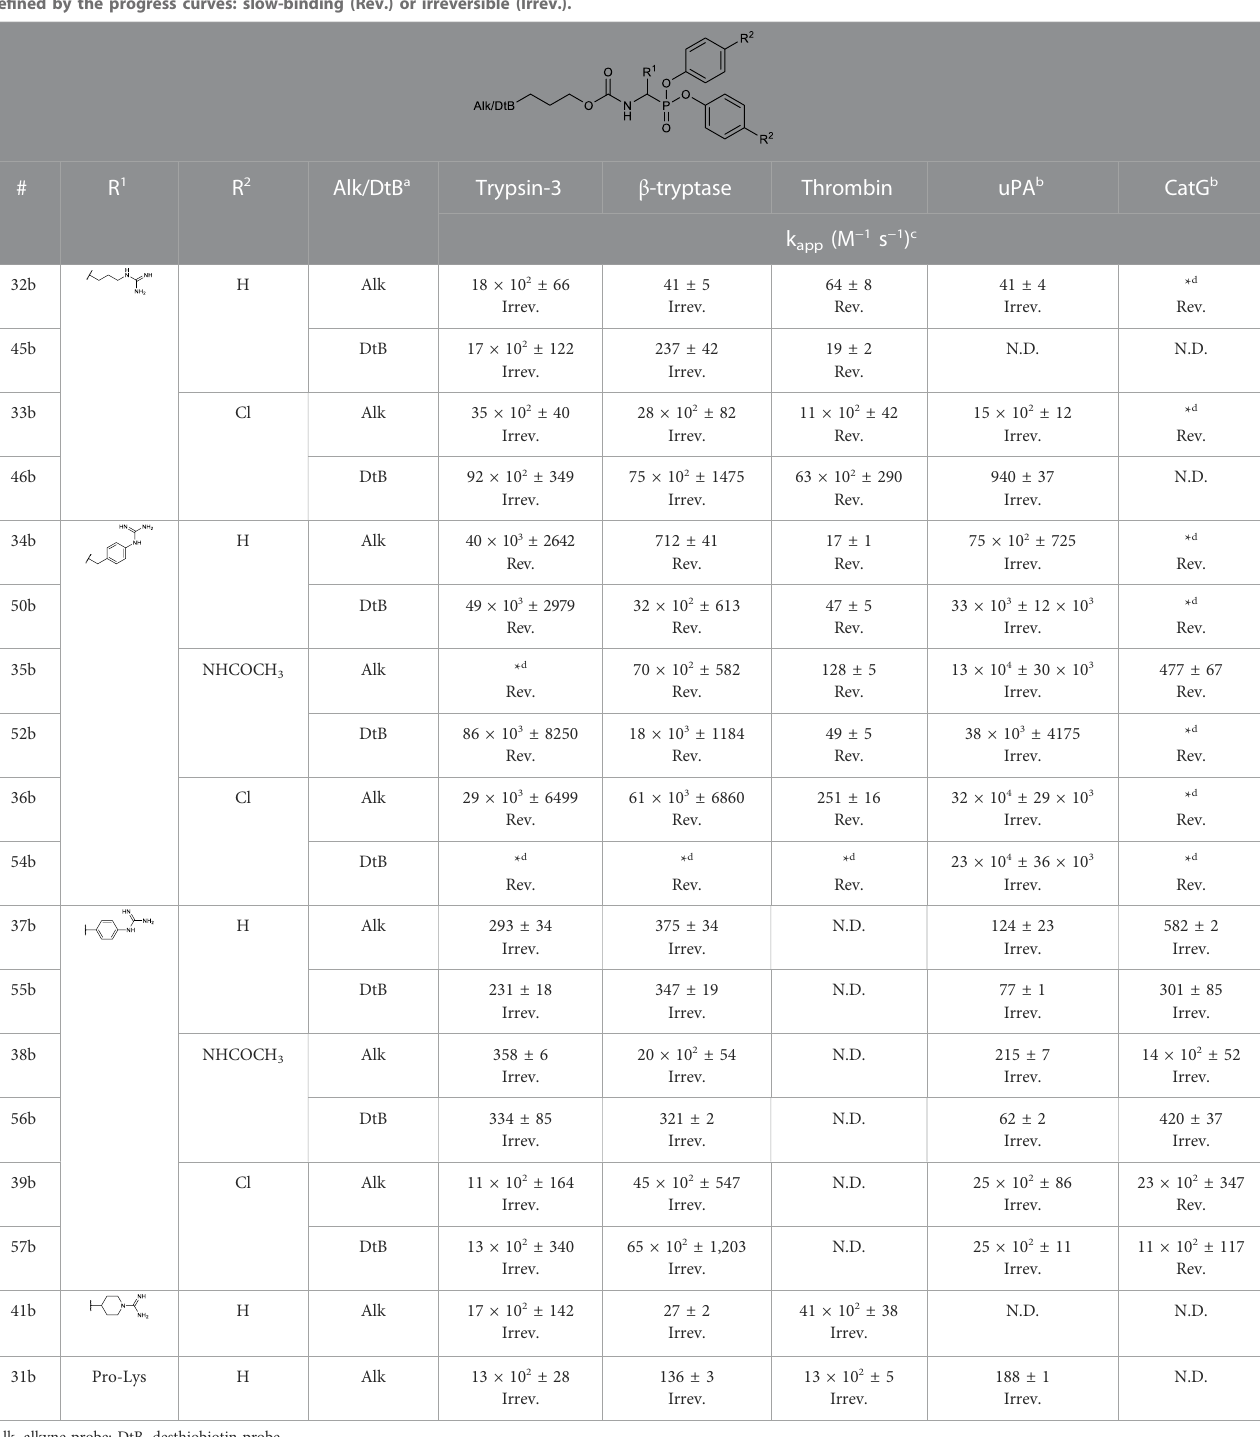
TABLE 4 k app values of selected alkyne and desthiobiotin probes against a panel of trypsin-like serine proteases and the description of the mechanism of inhibition de fi ned by the progress curves: slow-binding (Rev.) or irreversible